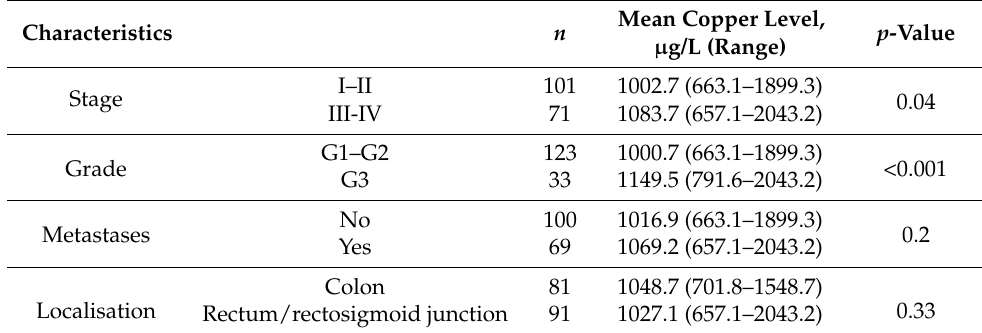
Table 5. Copper levels by colon cancer characteristics.